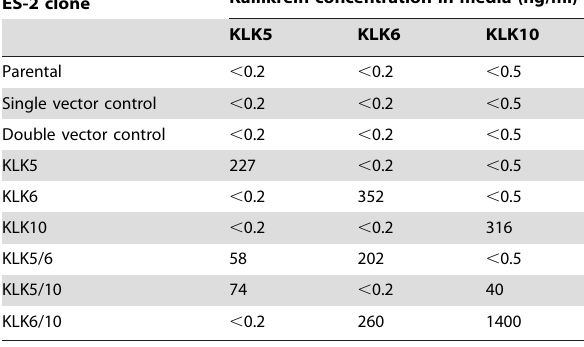
Table 2. Stable overexpression of KLK5, 6, and 10 alone or in pairs, in clones of the ES-2 cell line results in secretion of kallikreins into the culture media.